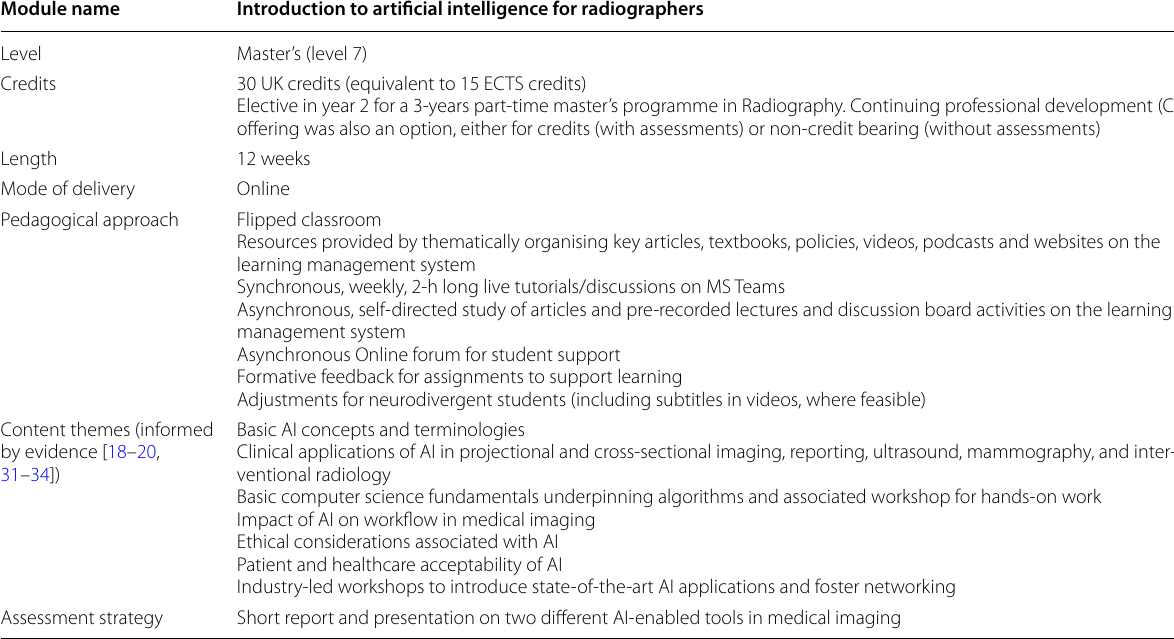
Table 1 Details about the AI module for